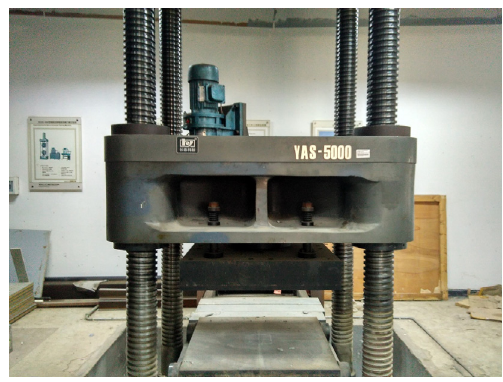
Figure 2. YAS ‐ 5000 compression ‐ testing machine. Figure 2. YAS-5000 compression-testing